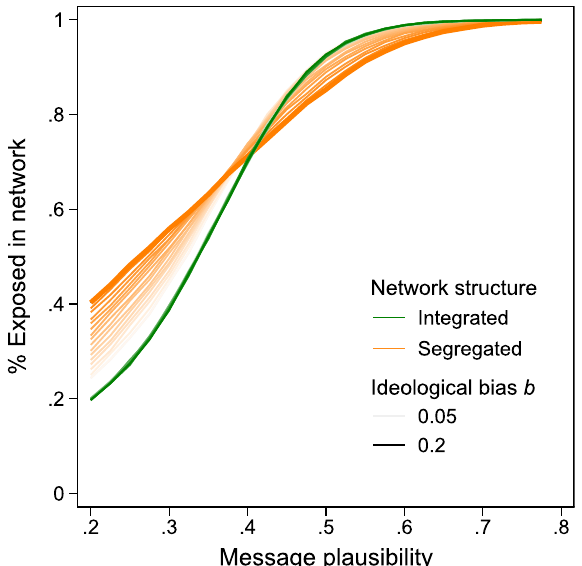
Figure 2. Theoretical expectations. We simulated diffusion processes in ring lattice networks as depicted in Fig. 1. Each diffusion process was seeded both in an integrated and in a segregated network ( N = 96). We varied baseline sharing probability p (0.2–0.8) and ideological bias b (0.05–0.2), see Materials and methods. We measure exposure as the percentage of network nodes that have received a certain message. The model predicts that network segregation raises exposure to low- p content and decreases exposure to content with higher levels of p , and does so more for greater bias b . We report simulation results as connected lines across different p